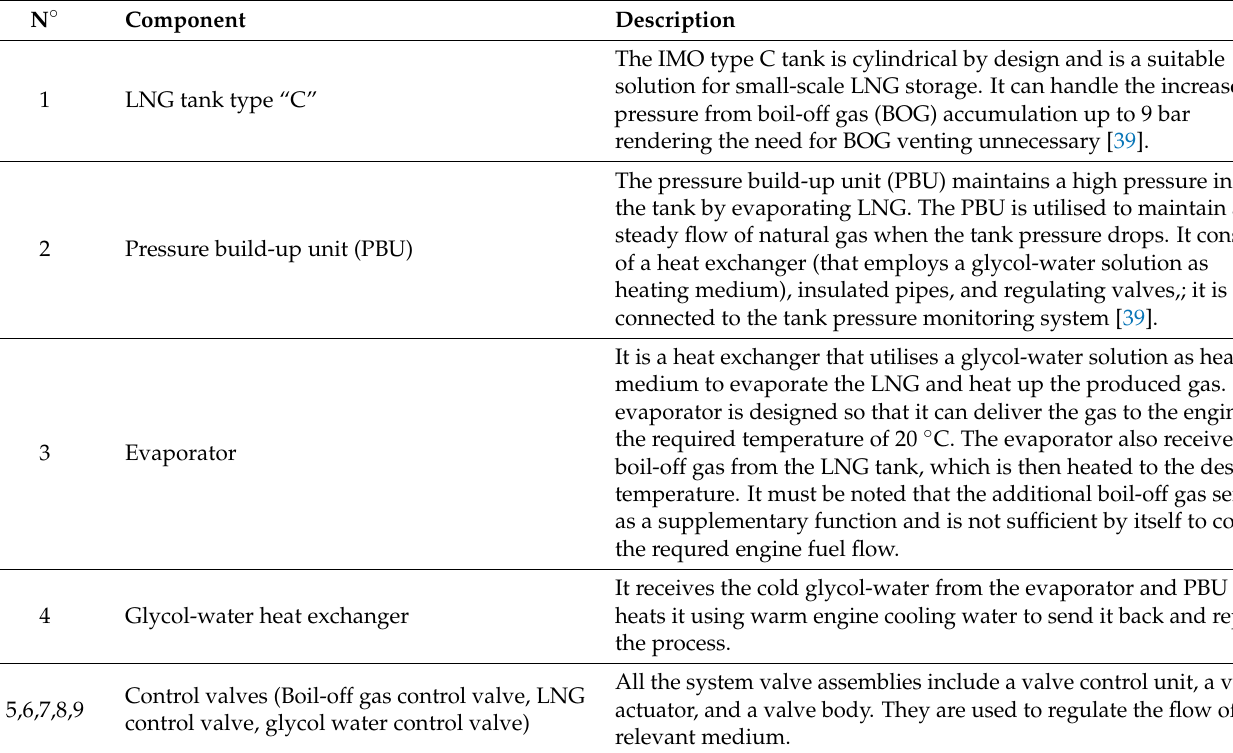
Figure 4. Low-pressure LNG fuel feeding system (adapted from [39]). Table 2. LNG feeding system components description.